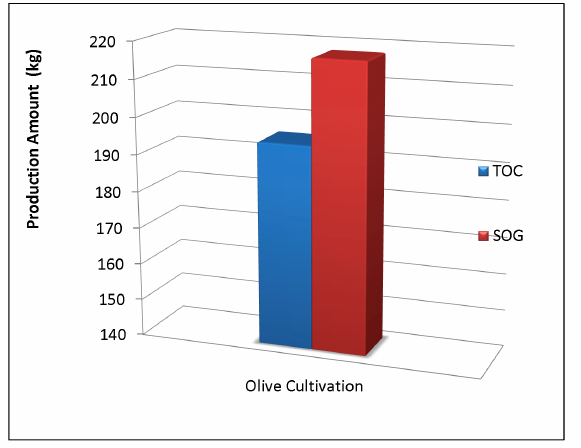
Figure 7. Production amount of SOG and the TOC. The average weight of the olive fruit from the SOG and TOC is presented in Figure 8. One hundred olives were randomly assigned from SOG and TOC separately for mean olive weight measurements. They were weighed and divided by their number. This process was repeated several times, and the results were averaged and documented in Figure 8. The average longitudinal diameter and cross diameter of SOG and TOC are viewed in Figure 9. Ten olives were randomly selected to measure the average longitudinal diameter. The longitudinal diameter of each fruit was measured, and the average results were taken. This process was performed separately for SOG and TOC methods.